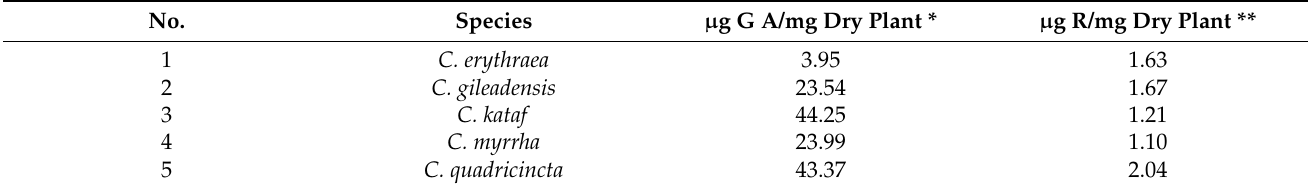
Table 7. Total of phenols and flavonoid contents of Commiphora species.